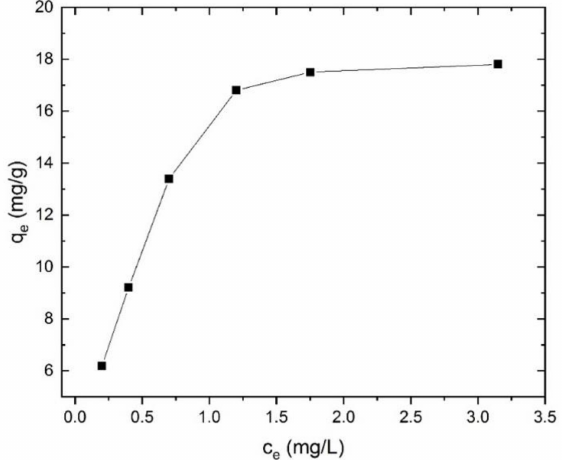
Figure 11. Experimental Tb 3+ loading isotherm. Temperature: 25 ◦